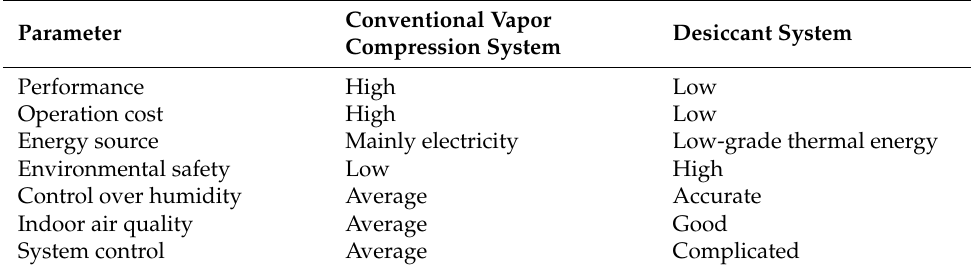
Table 3. Comparison between desiccant and conventional systems [113,116,119].